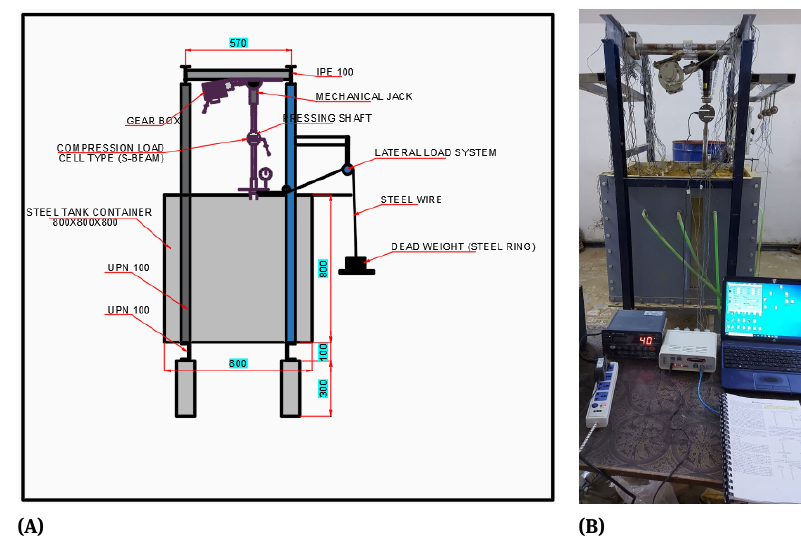
Figure 1: (A) Sketch for lateral and vertical load system. (B) Under-reamed pile testing